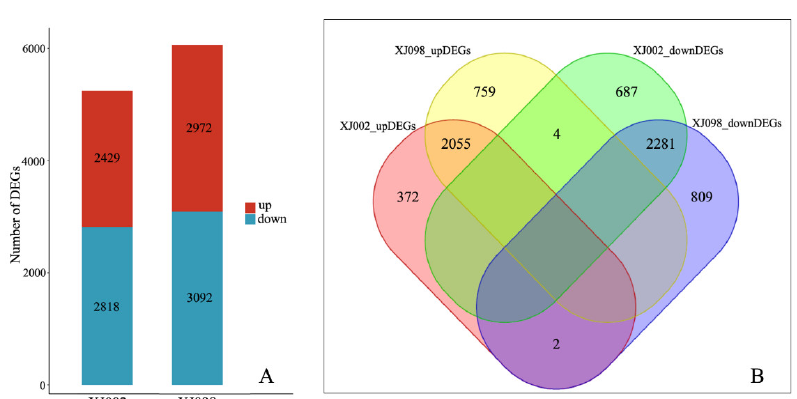
Figure 3. RNA-Seq analysis of two Ae. tauschii with contrasting drought tolerance. ( A ): Number of DEGs in both tolerant and sensitive genotype (red = up-regulated; blue = down-regulated). ( B ): Venn diagram of unique and common DEGs between the two genotypes.